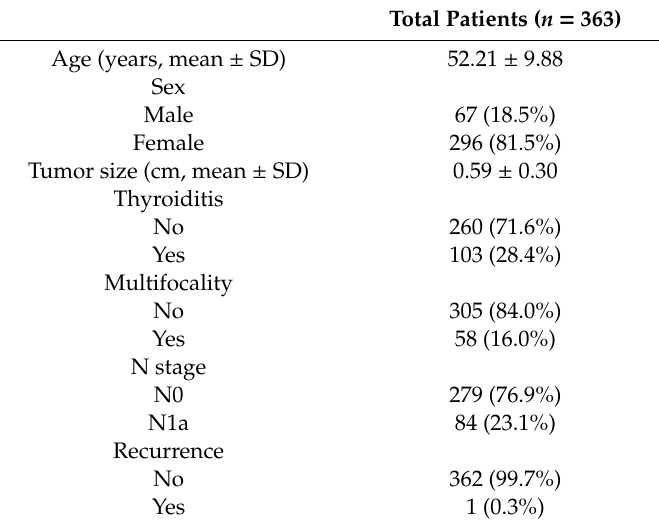
Table 1. Baseline characteristics of patients with low-risk papillary thyroid carcinoma who underwent lobectomy and received